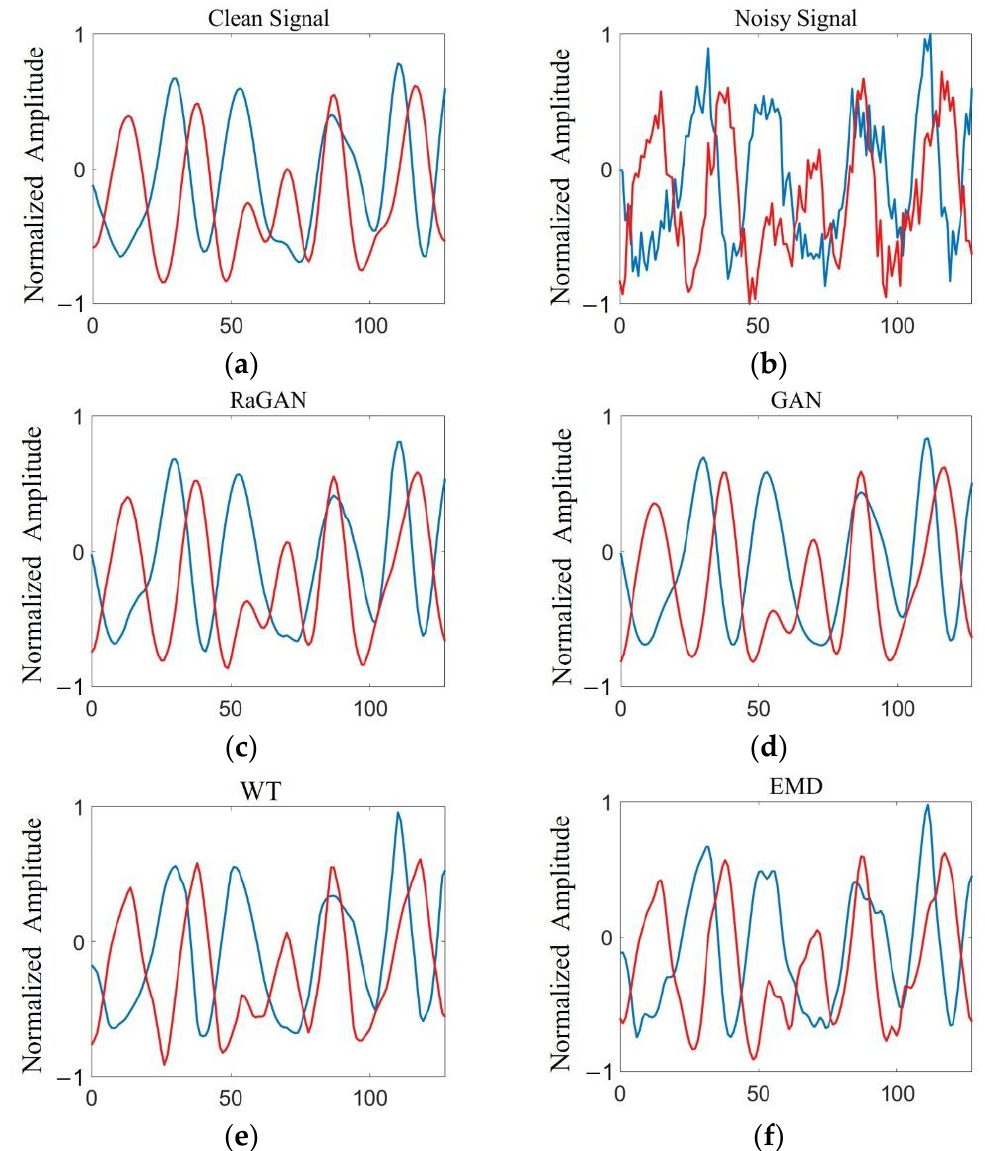
Figure 5. Time-domain waveform comparison of 8PSK signal before and after noise reduction: ( a ) original clean signal waveform; ( b ) noisy signal waveform; ( c ) time-domain waveform of signal af- ter RaGAN noise reduction; ( d ) time-domain waveform of signal after GAN noise reduction; ( e ) time-domain waveform of signal after WT noise reduction; ( f ) time-domain waveform of signal after EMD noise reduction.